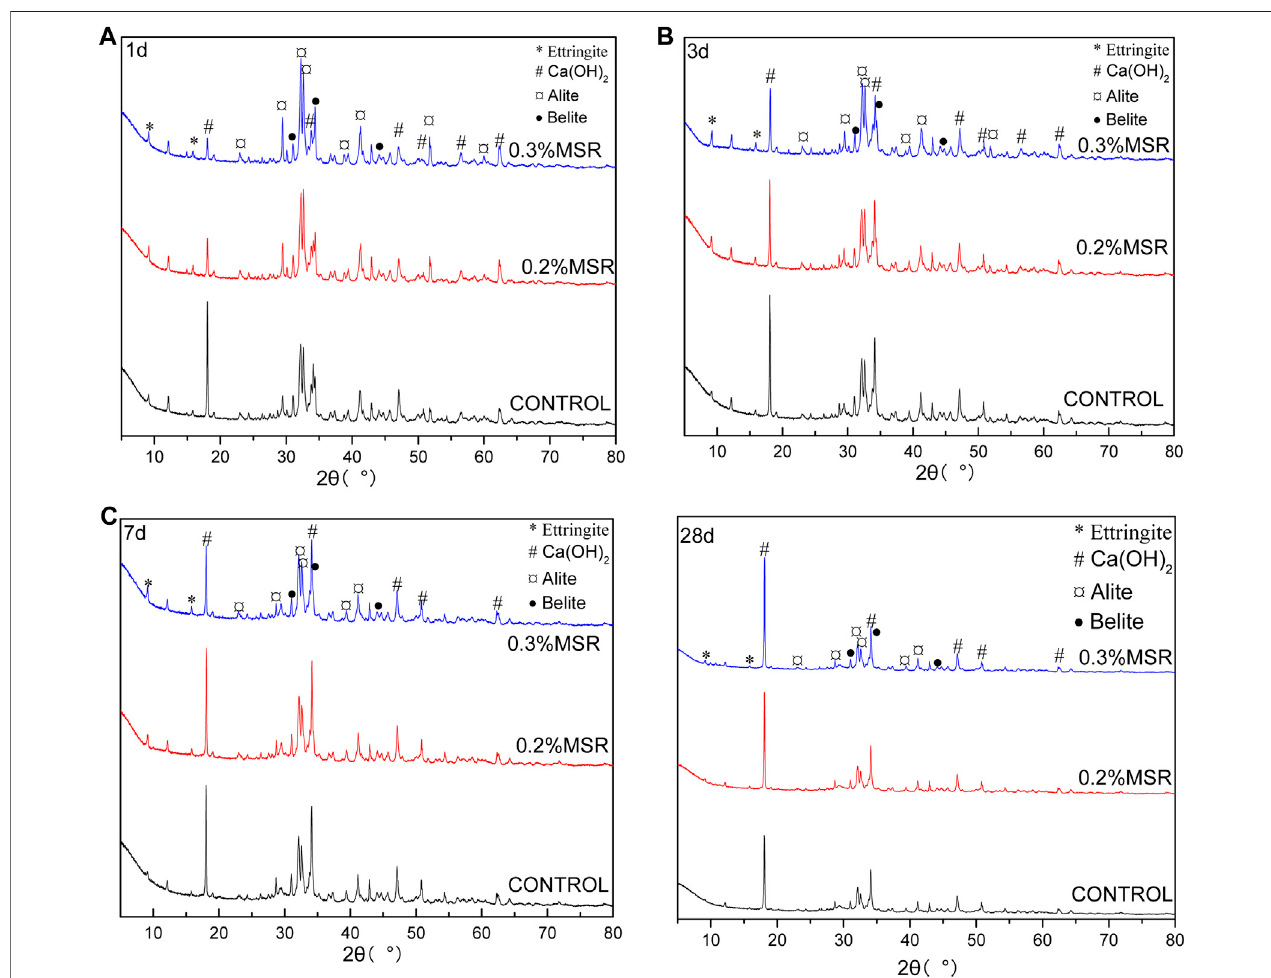
FIGURE 11 | XRD patterns of cement paste with MSR: (A) 1 day; (B) 3 days; (C) 7 days.